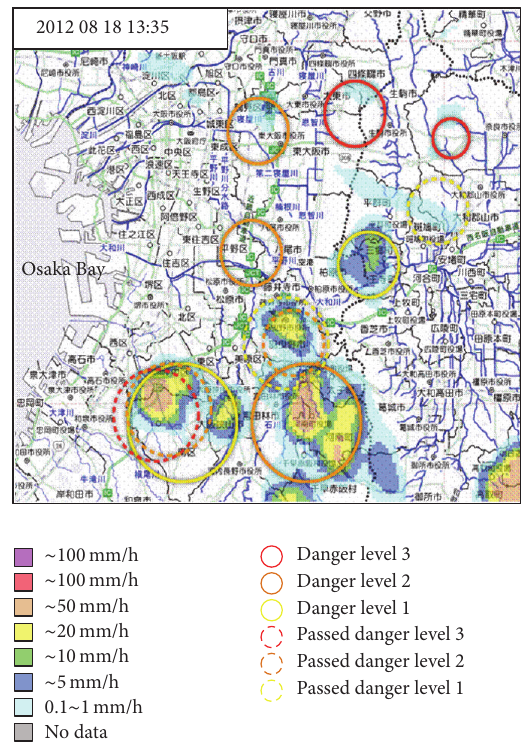
Figure 10: One example of the results using the Guerrilla-heavy rainfall prediction system by radars of the MLIT [20]. Circles in different colors denote the dangerous range and the corresponding danger level.